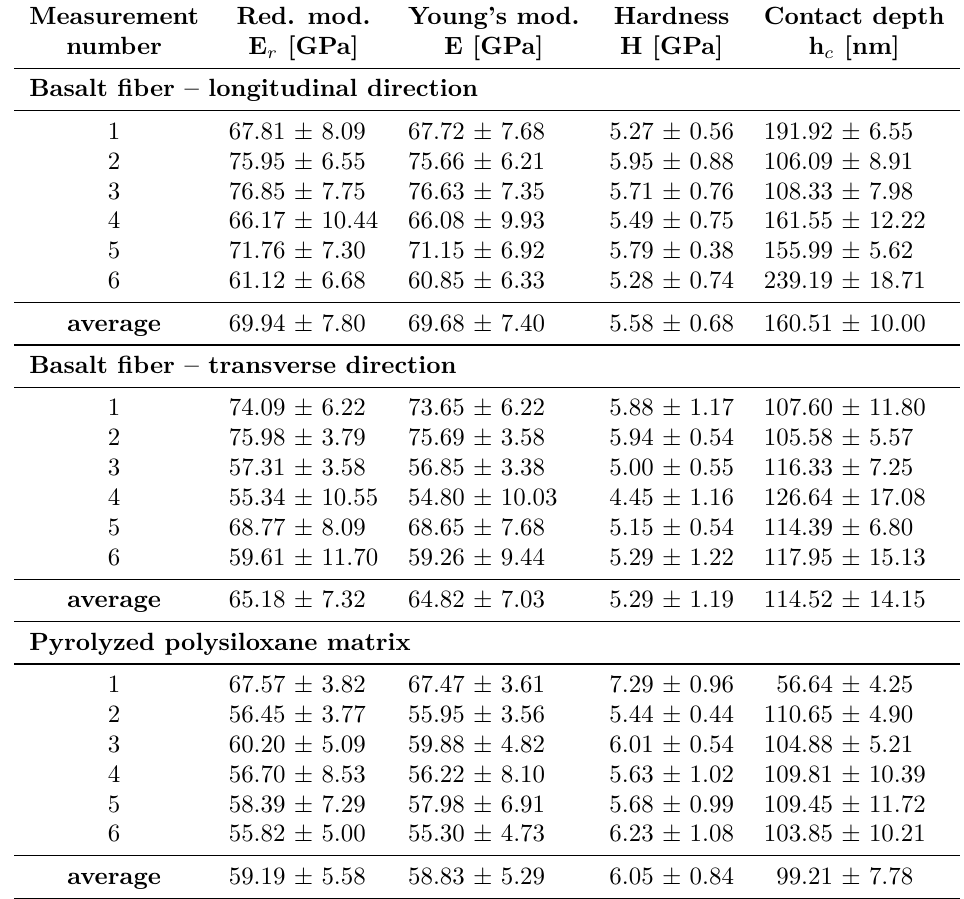
Table 1. Indentation results of individual material phases.